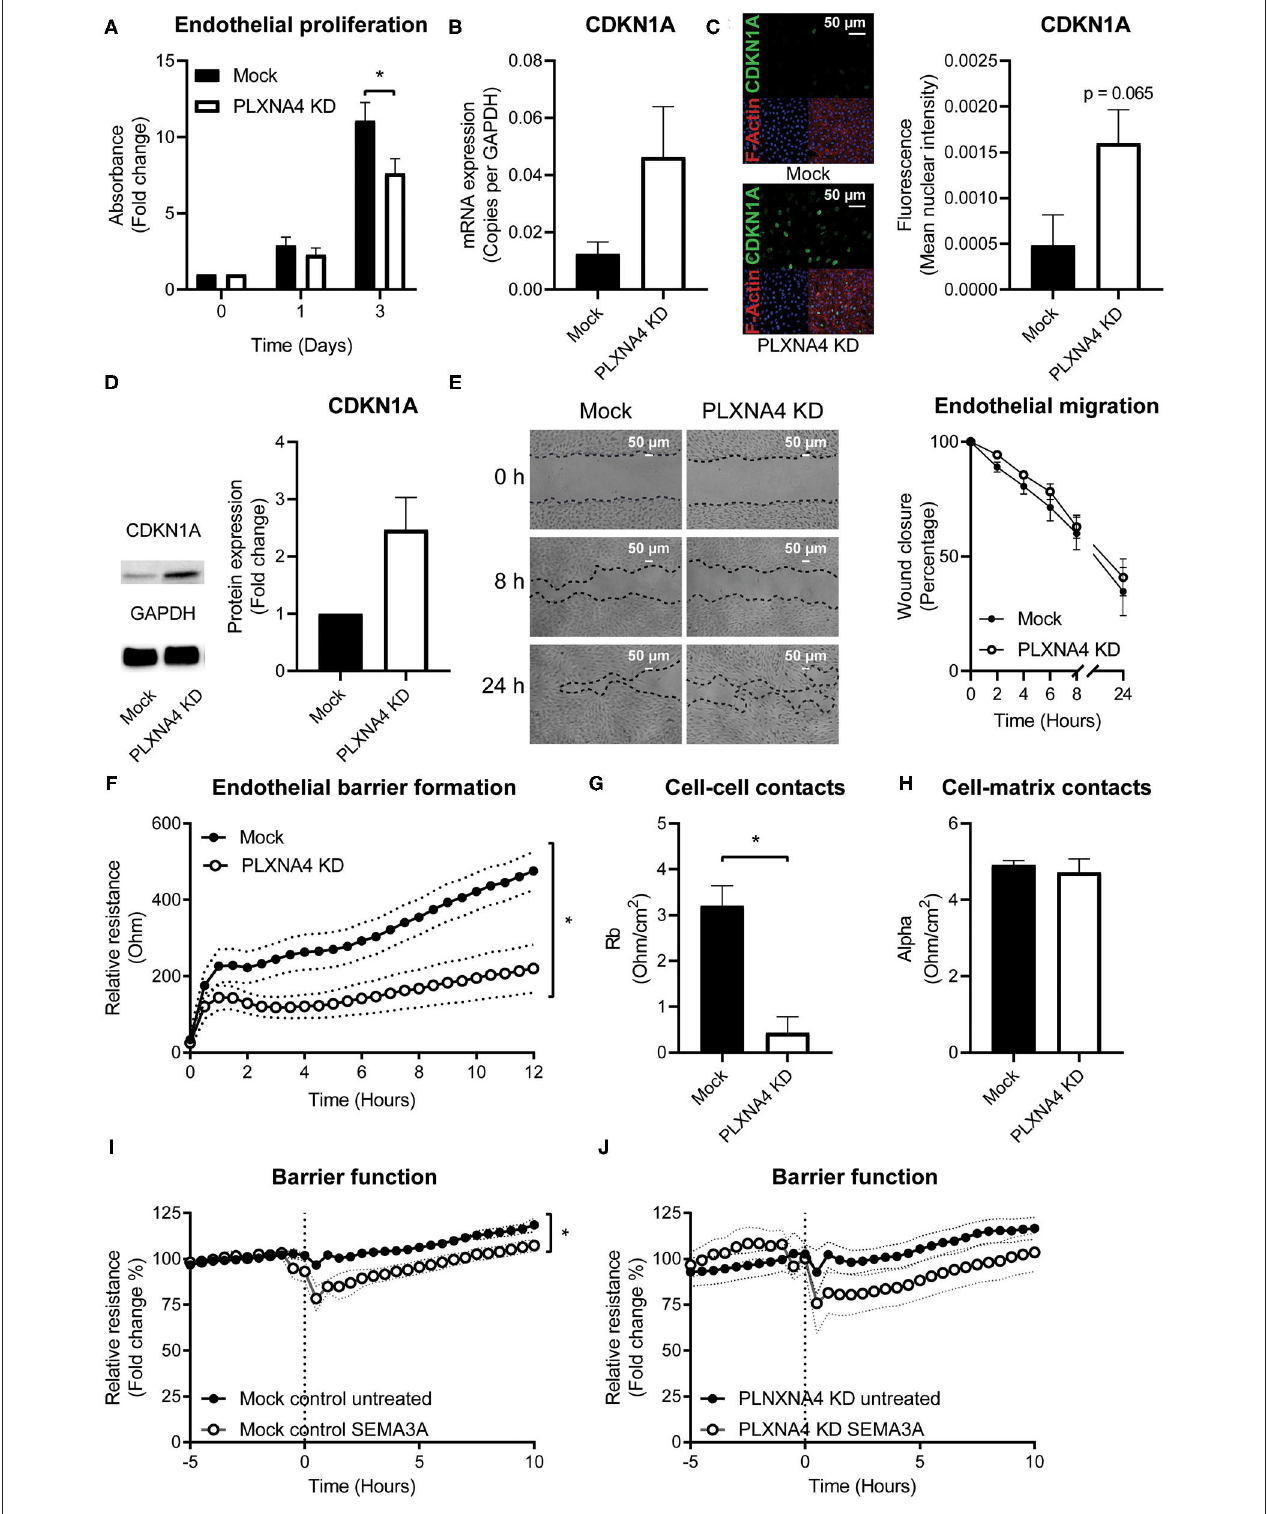
FIGURE 3 | Loss of endothelial PLXNA4 reduces cell proliferation and barrier function. (A) Proliferation of mock and PLXNA4 KD endothelial cells. Results are expressed as fold change to day 0 set at 1. Mean ± S.E.M. of N = 6, * P < 0.05. (B) mRNA expression of CDKN1A in mock or PLXNA4 KD endothelial cells. Results are expressed as copies corrected for GAPDH. Mean ± S.E.M. of N = 8. (C) Representative overview photographs and quantification of CDKN1A staining of mock